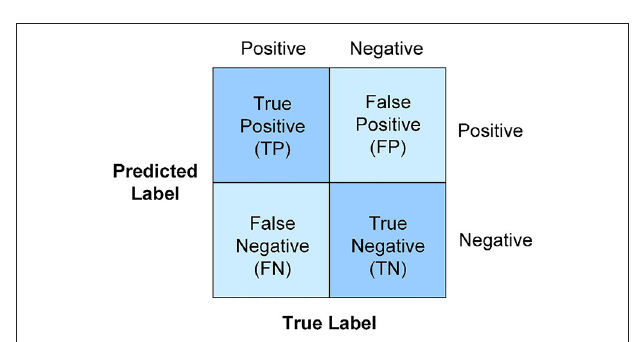
FIGURE 2 | Confusion matrix. The accuracy, precision, recall, F1-score, and AUC mainly rely on the counts of instances correctly and incorrectly